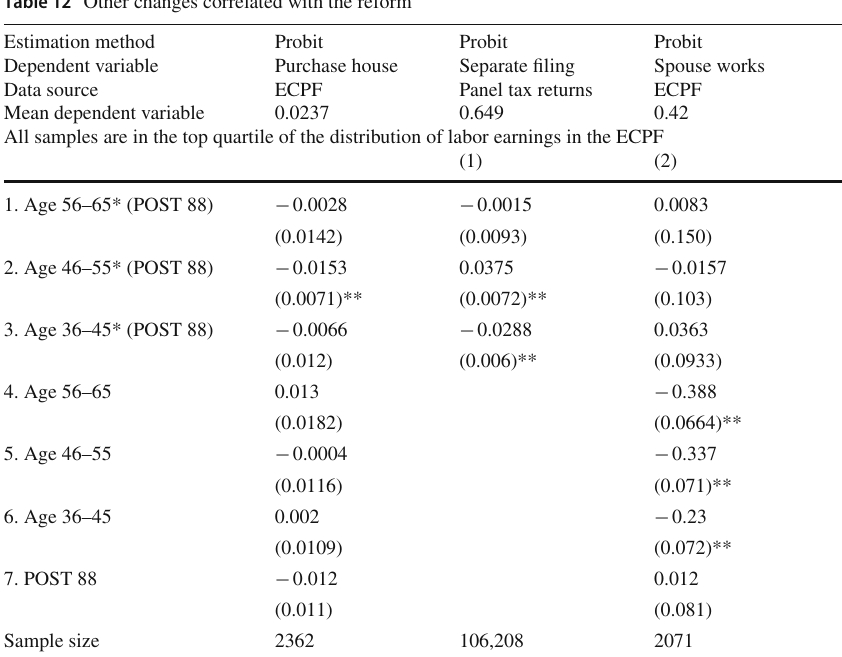
Table 12 Other changes correlated with the reform Estimation